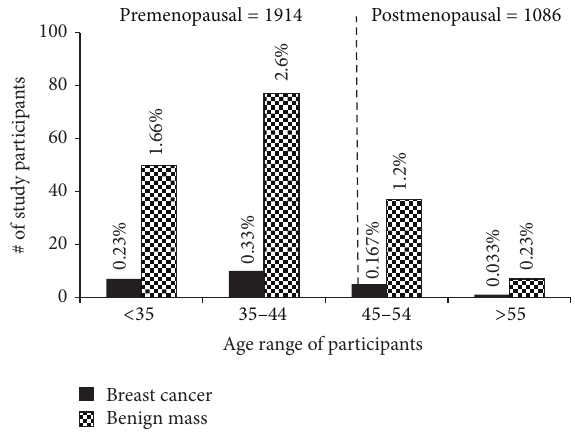
Figure 3: Incidence of breast cancer and breast mass in pre- and postmenopausal participants. Incidence of breast cancer and breast mass is shown in the various age groups in pre- and postmenopausal participants. Notably, most of the participants diagnosed with breast cancer were premenopausal with a mean age of 38 years and seven (7) participants diagnosed were below 35 years. A single benign mass case was observed in the 71 participants between 45 and 46.6 years. More details including histological classifications of the cases are shown in Table 1. Percentages shown for each age group were calculated based on number of breast disease cases diagnosed in each group over total number of participants. 𝑃 < 0.005